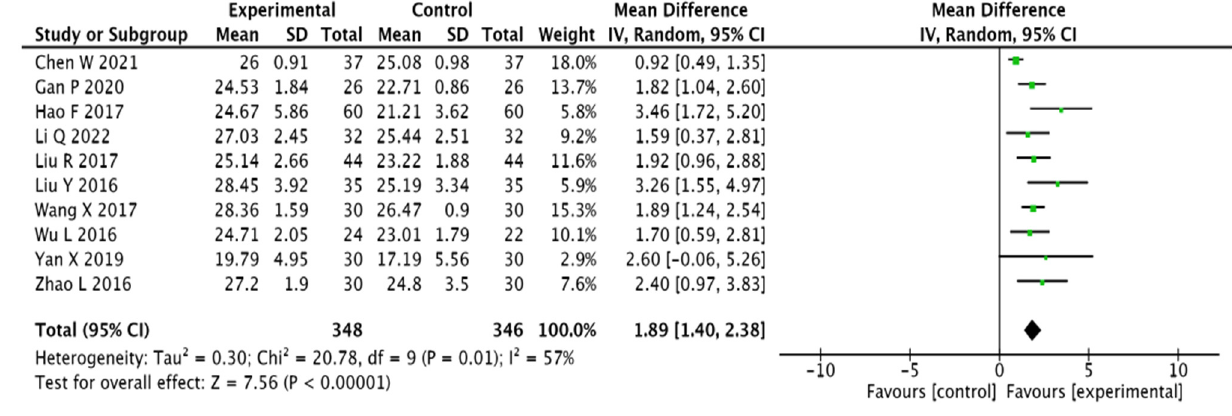
Figure 6. Forest plot of MMSE scores [13,14,16,20–26].